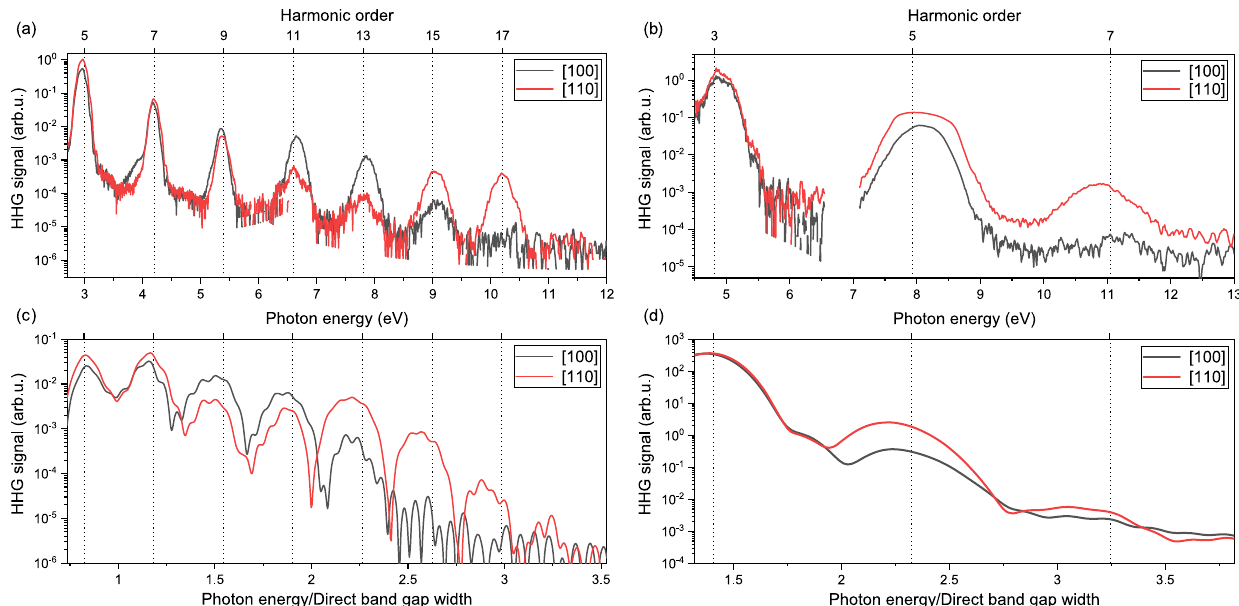
Fig. 1 High harmonic spectra in silicon. a , b Experimental high harmonic spectra (HHG signal) re fl ected from monocrystalline silicon with linear polarization of the driving pulse along [100] (black curves) and [110] (red curves) crystallographic directions. The central photon energies of the driving pulses are a 0.6 eV (wavelength of 2000 nm) and b 1.65 eV (wavelength of 750 nm). The peak intensity is I 0 = 3 TW/cm 2 in both a and b . c , d High harmonic spectra for both polarization directions of the driving pulses and the same photon energies as used in a and b calculated using time-dependent density functional theory with Tran-Blaha (TB09)